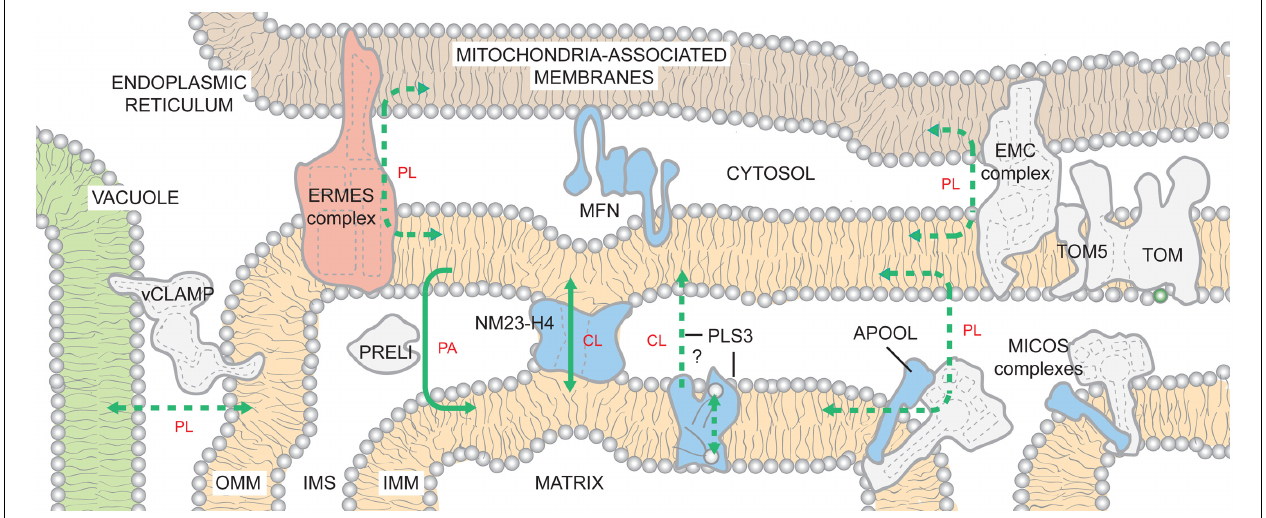
FIGURE 3 | Inter-organelle and intra-organelle phospholipid trafficking. The existence of ER- and vacuole-mitochondria contacts is highly conserved from yeast to humans. By generating closely appositioned membranes, the inter-organelle and intra-organelle tethers are hypothesized to promote movement of lipids across the aqueous cytosol and IMS, respectively.Within the mitochondrion, phospholipid trafficking may involve contacts between the OMM and the IMM mediated by MICOS complexes or NM23-H4. In addition, PRELI transports PA from the OMM to the IMM. PLS3 activity stimulates CL externalization on OMM. It may directly transport CL from the IMM to the OMM or instead function as a scramblase that redistributes CL between both leaflets of the IMM. CL now exposed to IMS-side of IMM would then be